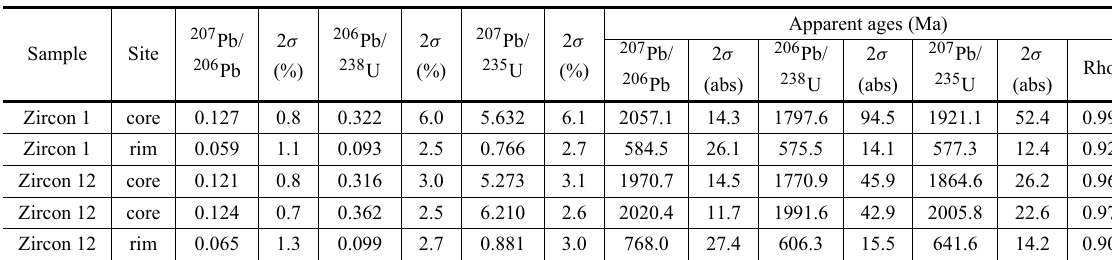
Results of in situ U-Pb LA-MC-ICP-MS zircons analyses.